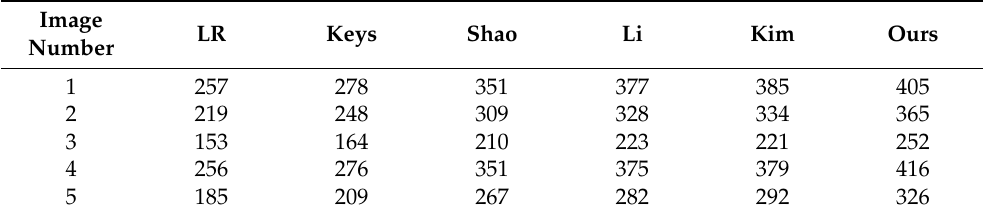
Table 3. The number of feature points detected in images reconstructed by different methods.